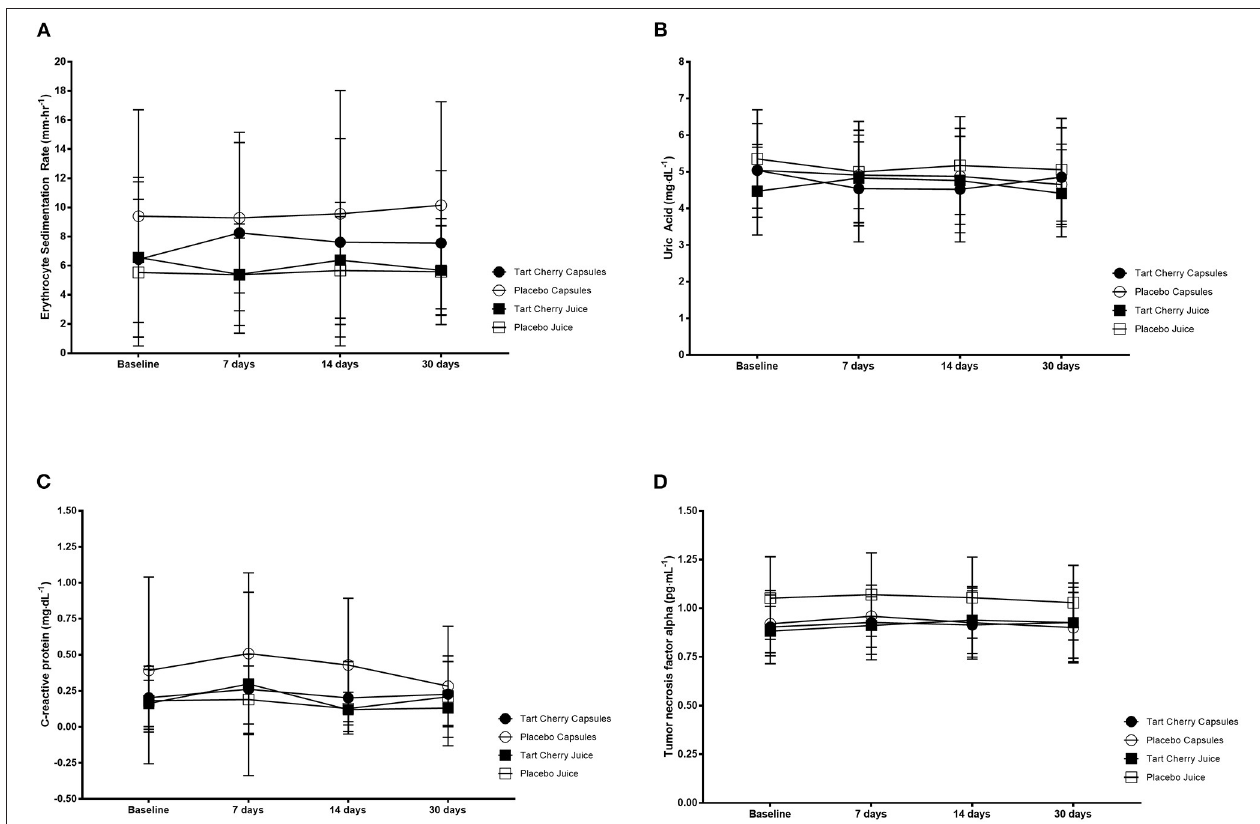
FIGURE 4 | Inflammatory markers including erythrocyte sedimentation rate (A) , uric acid (B) , C-reactive protein (C) and tumor necrosis factor alpha (D) for each group at baseline and after 14 and 30 days of supplementation with placebo or Montmorency tart cherry (MTC) concentrate or capsules.